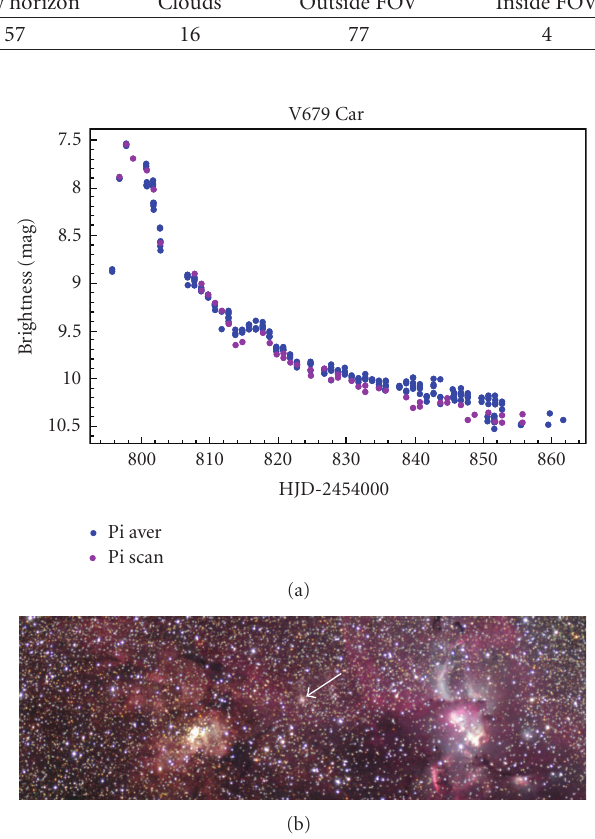
Figure 10: (a) shows a light curve of V679 Car. Data are taken from the “Pi of the Sky” database. Blue points denote measurements taken during all-sky scans and violet points from regular observations. (b) shows an optical image of the V679 Car (indicated by an arrow) taken by Alain Maury, Steve Barnes, Caisey Harlingten, and Stephane Guisard on December 1,